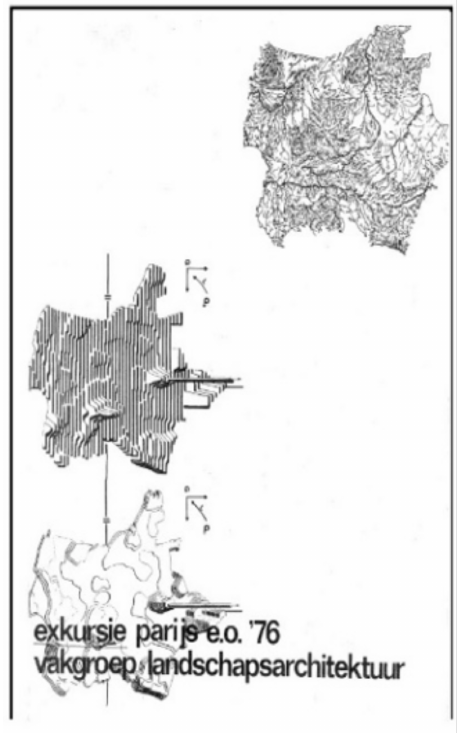
Figure 17. Excursion guide for landscape architecture students Wageningen to Paris in 1976